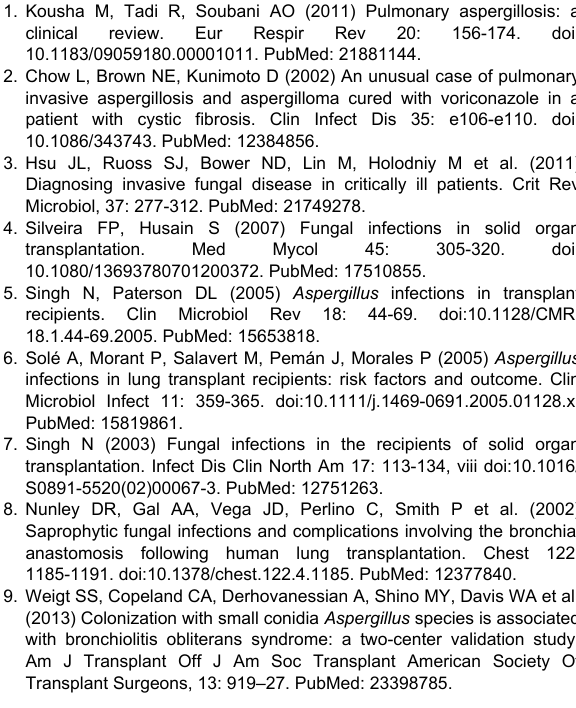
Figure S1. Experimental approach: intra-tracheal injection. Animals were inoculated with A. fumigatus (3-4 x 10 8 conidia/ml in 40 μl volume). All animals were euthanized 2 days after the day of infection as denoted by the letter “X”. All animals received triamcinolone acetonide (40mg/kg) on day of infection.